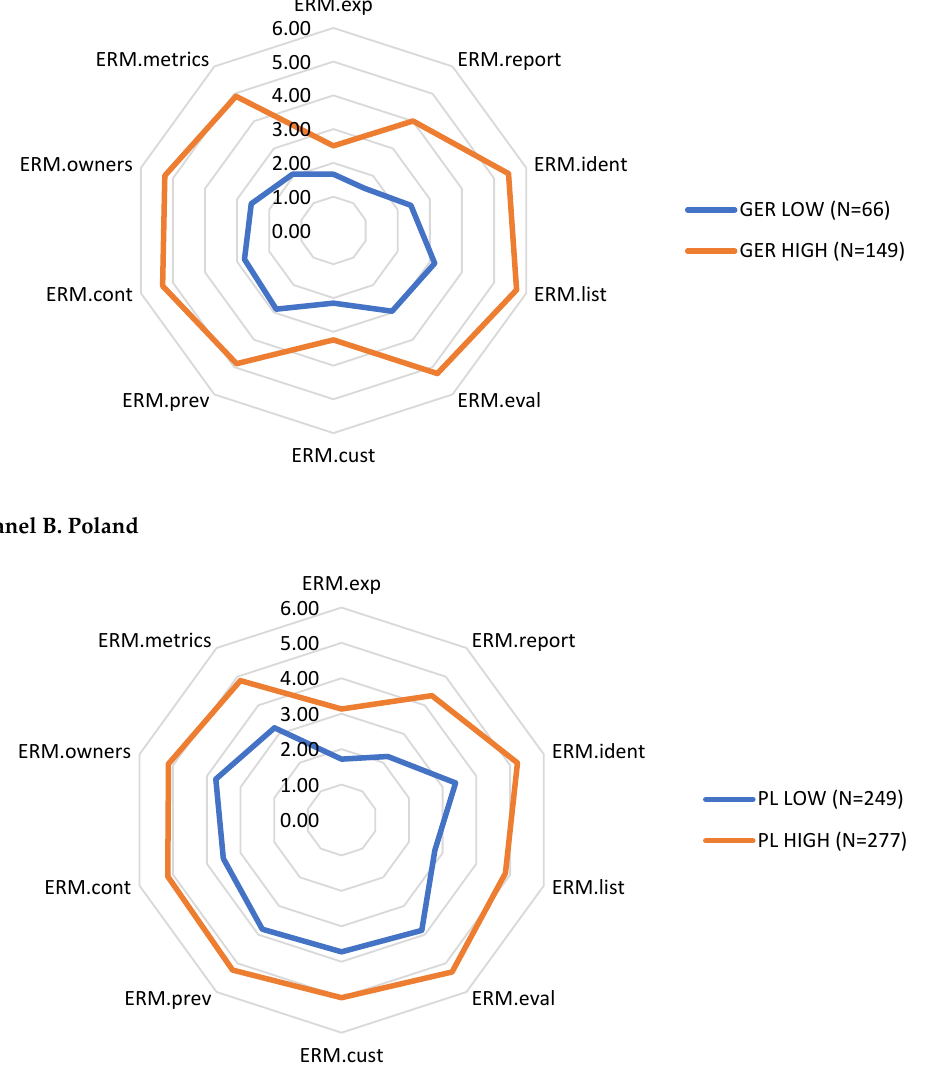
Figure 5. Clusters of low and high ERM sophistication (mean values of the scores, for Germany and Poland).